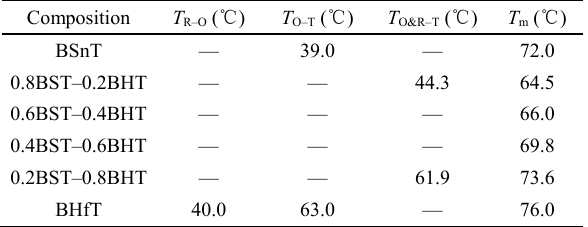
Table 2 Phase transition temperature based on dielectric properties at 1 kHz for x BSnT–(1 − x )BHfT ceramics